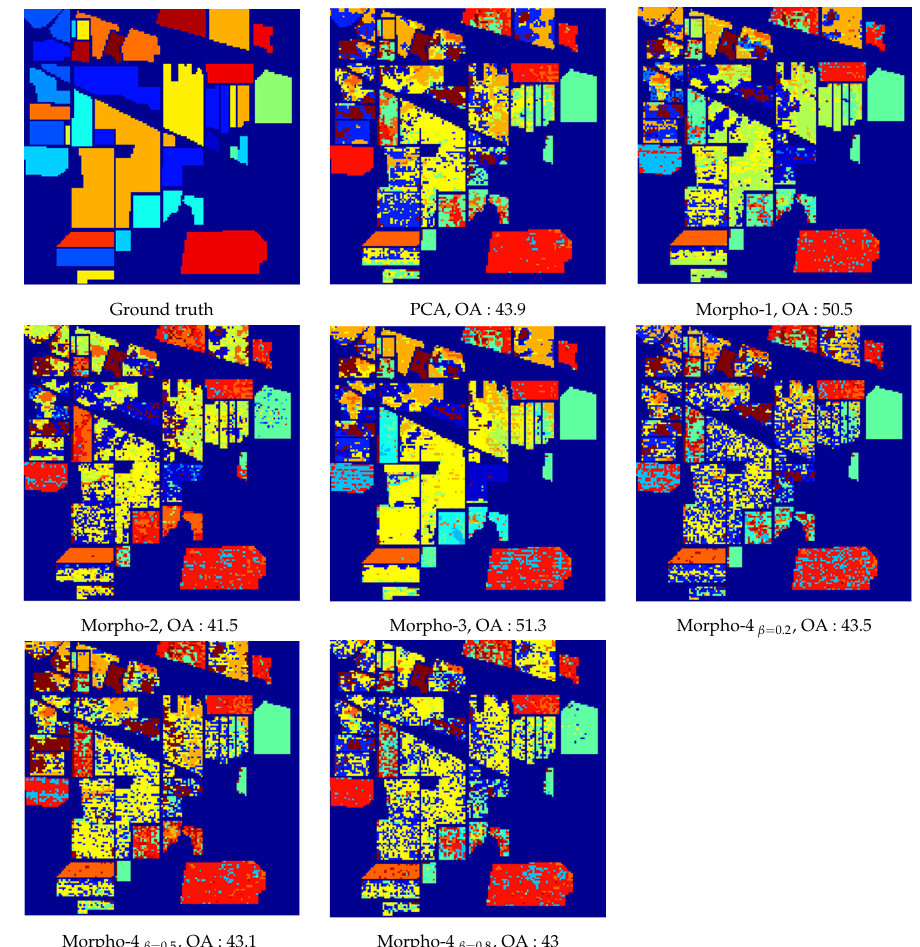
Figure 16. Results of supervised classification using least square SVM with a linear kernel on Indian Pines hyperspectral image. Note the OA is the overall